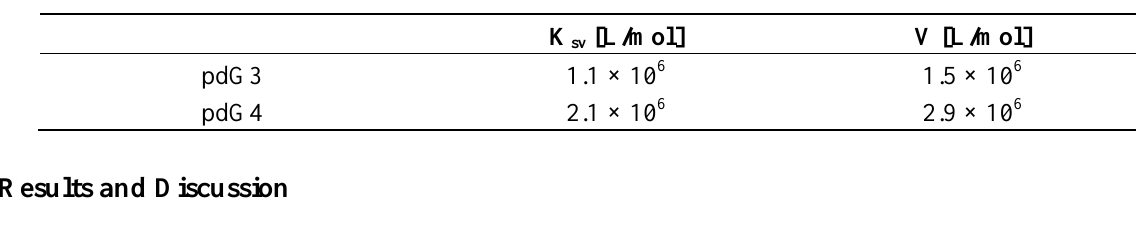
Table 1. Stern–Volmer constants for quenching of ethidium bromide bound to siRNA fluorescence by phosphorus dendrimers.